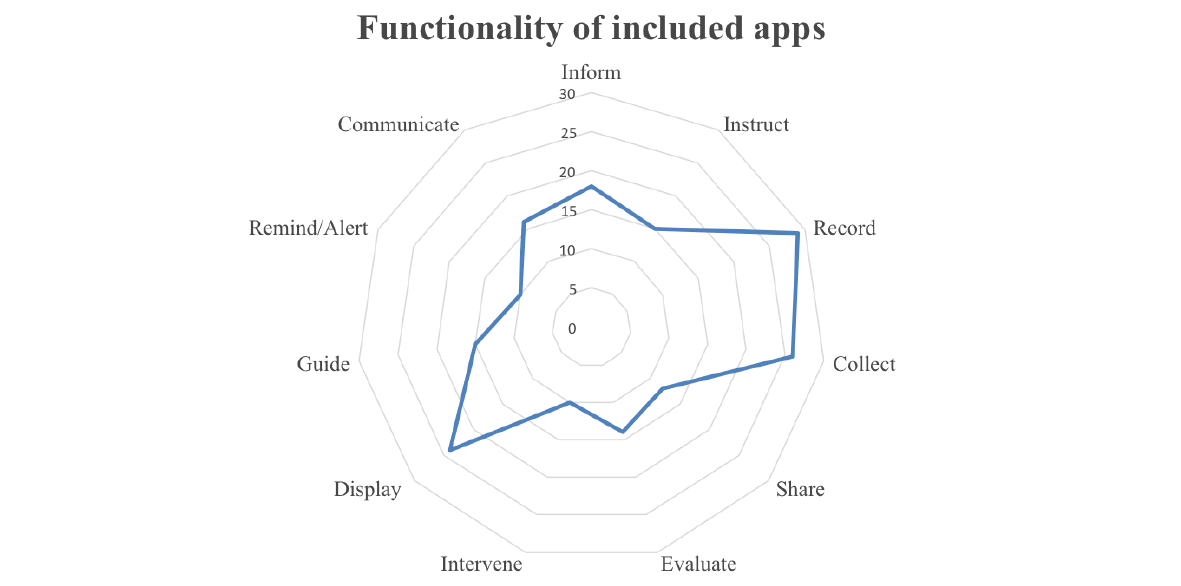
Figure 2. Functionality of included apps based on IMS Institute for Healthcare Informatics functionality